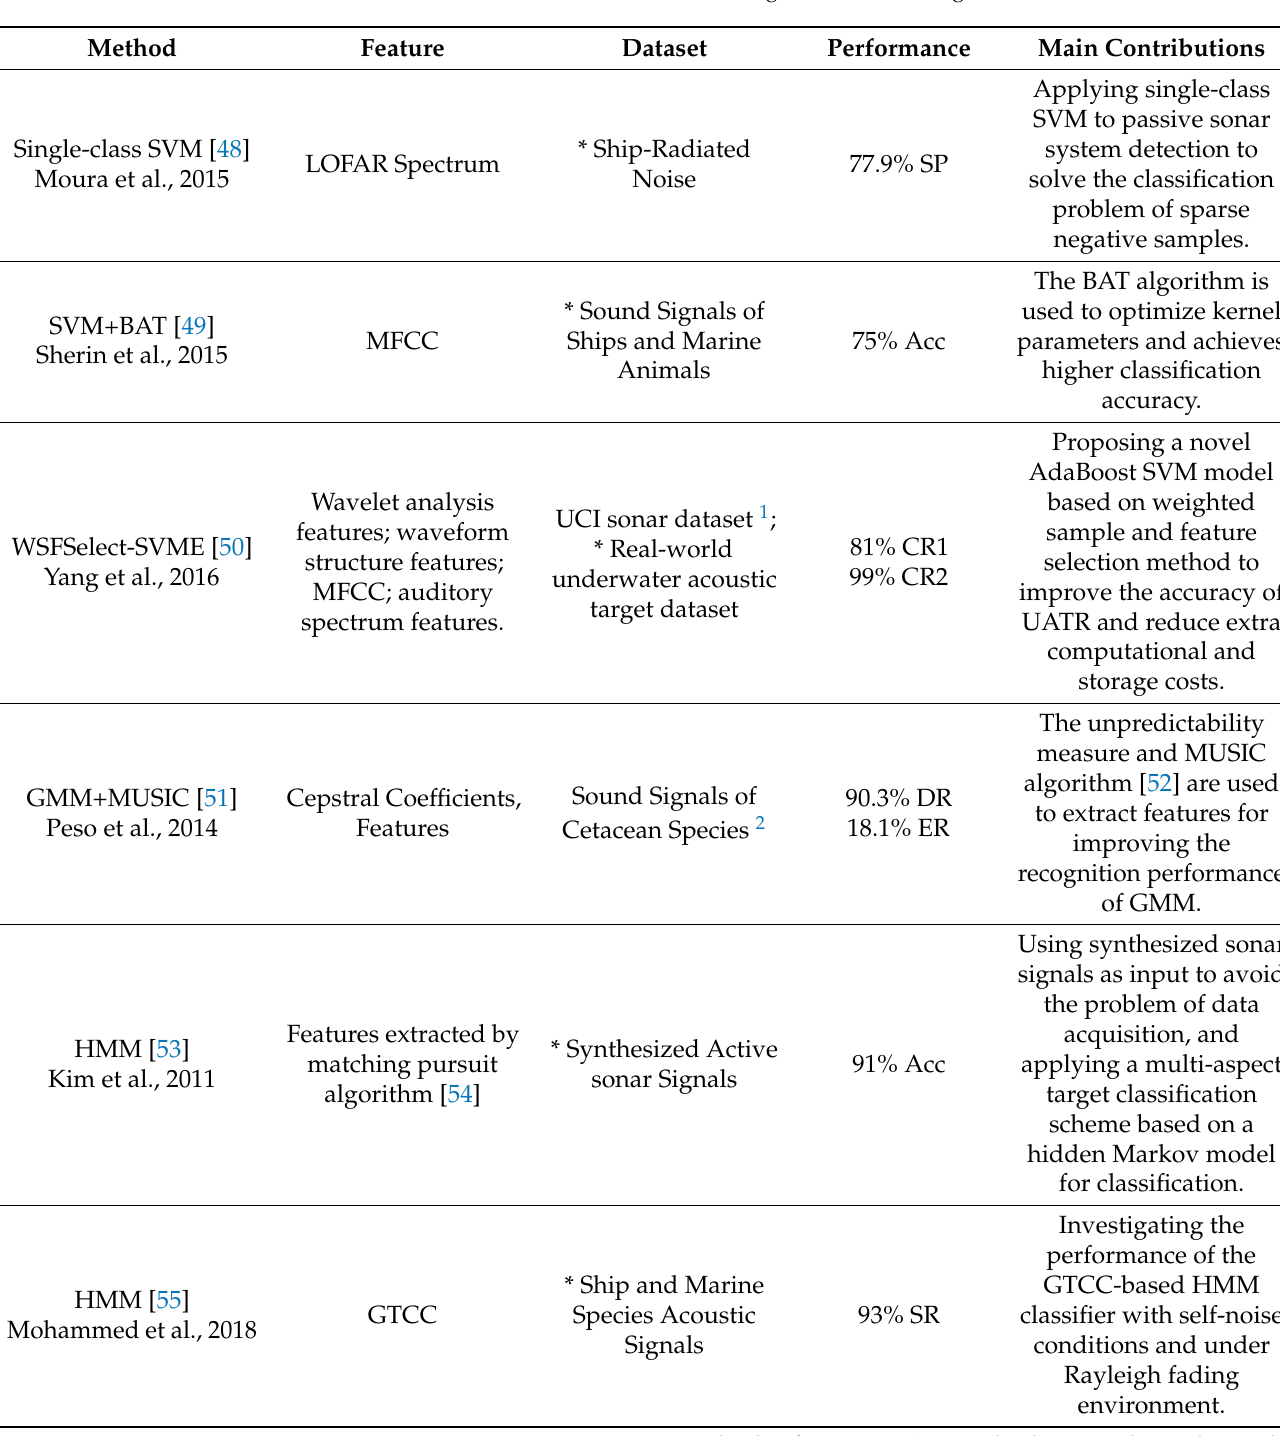
Table 1. An overview of UATR methods using statistical